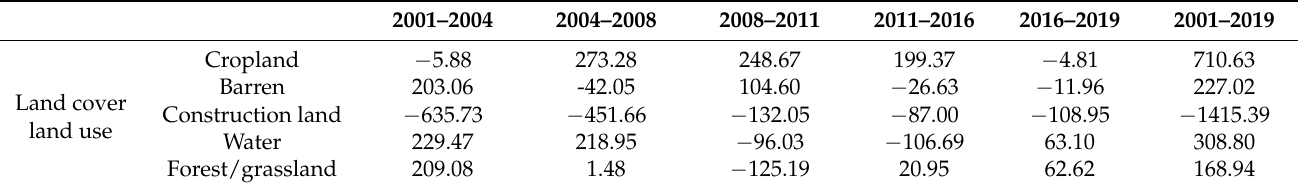
Table 2. Land cover land use changed for different types in the GBA (km 2 ).